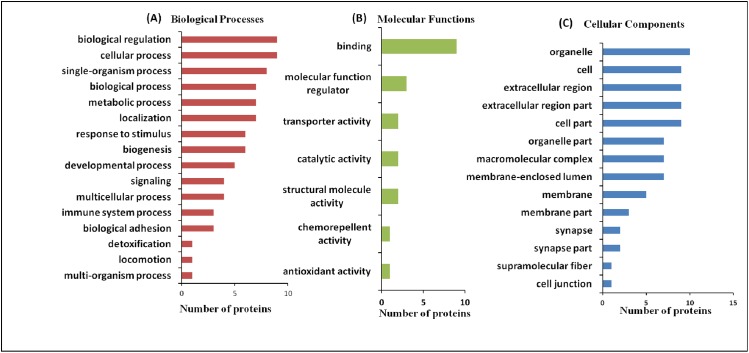
Functional classification of differentially expressed proteins identified in three case groups.(A) The biological processes, (B) molecular functions, and (C) cellular components regulated by differentially expressed proteins by Gene Ontology search.